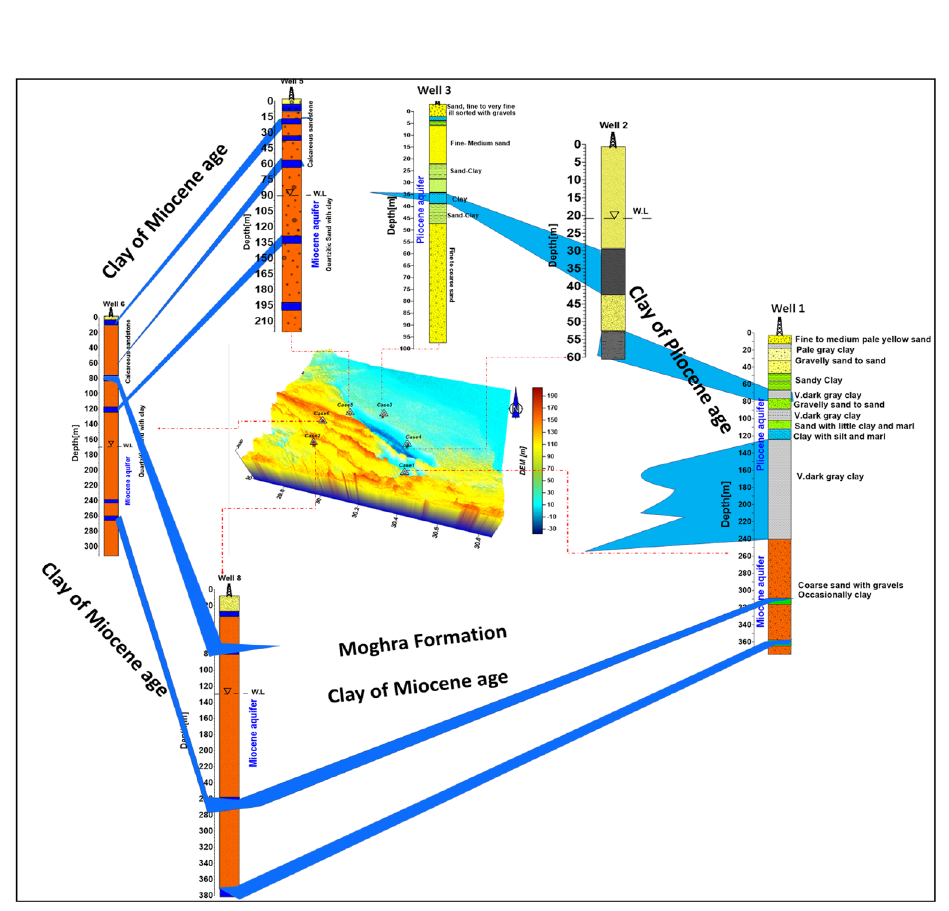
Figure 13. 3D view of the initial models (drilled water wells) of resistivity inverted models of 1D VES with the expected clay layer/lens all over the studied